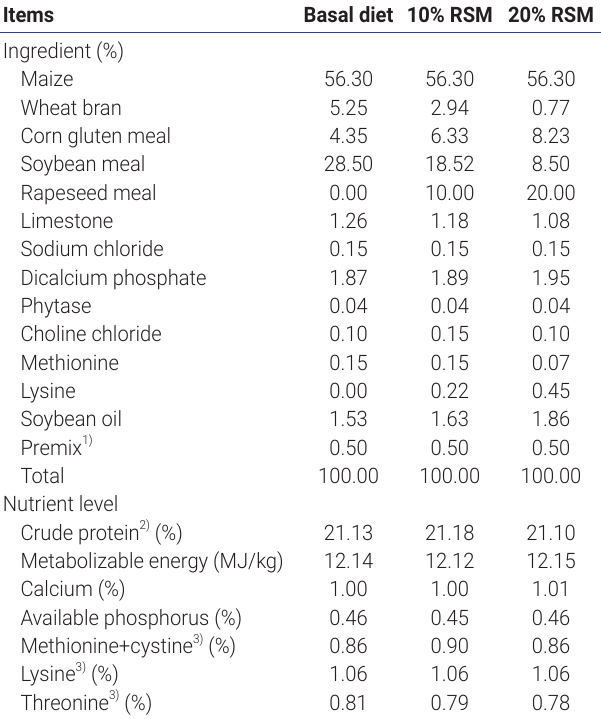
Table 1. The ingredients and nutritional levels of